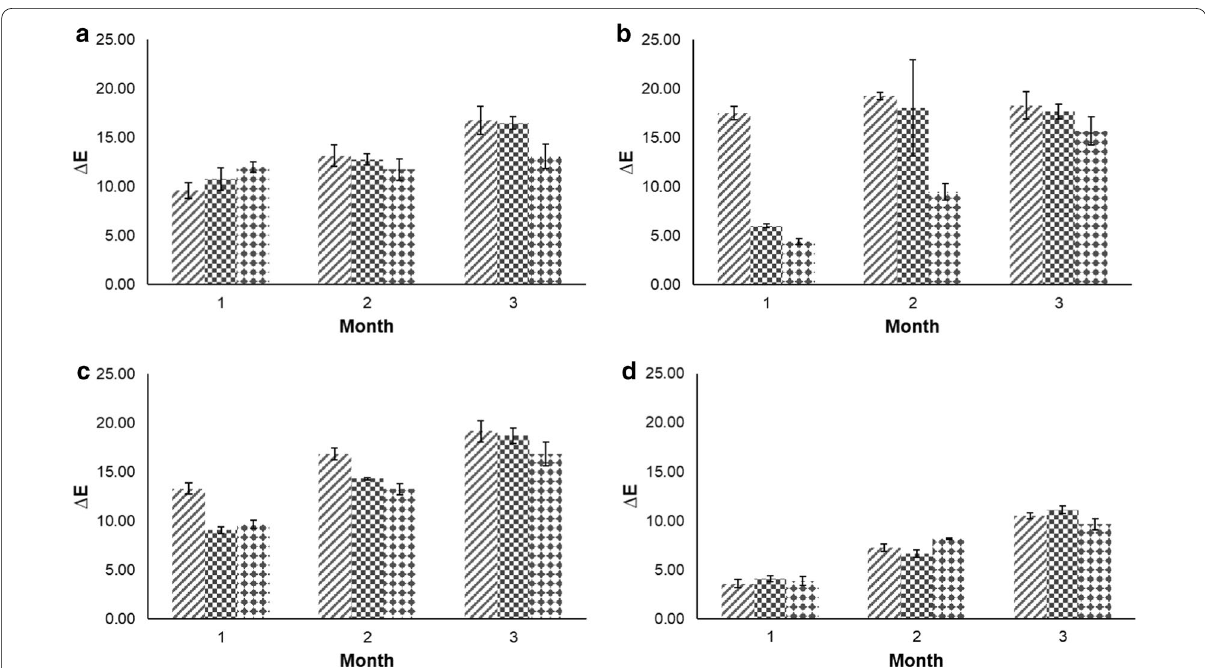
Fig. 2 Net color changes of mamey and carrot carotenoid microcapsules during storage. “Division slash” (25 °C in daylight); “Filled rectangle” (25 °C without access to daylight); “Filled diamond” (4 °C without access to daylight). a M AG 5, b M AG 10, c C AG 5 and d C AG 10. The data shown correspond to means SDs ( n ± =